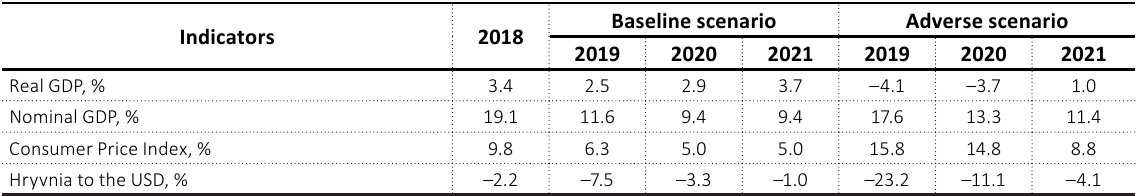
Source: Actual values and official forecasts of the